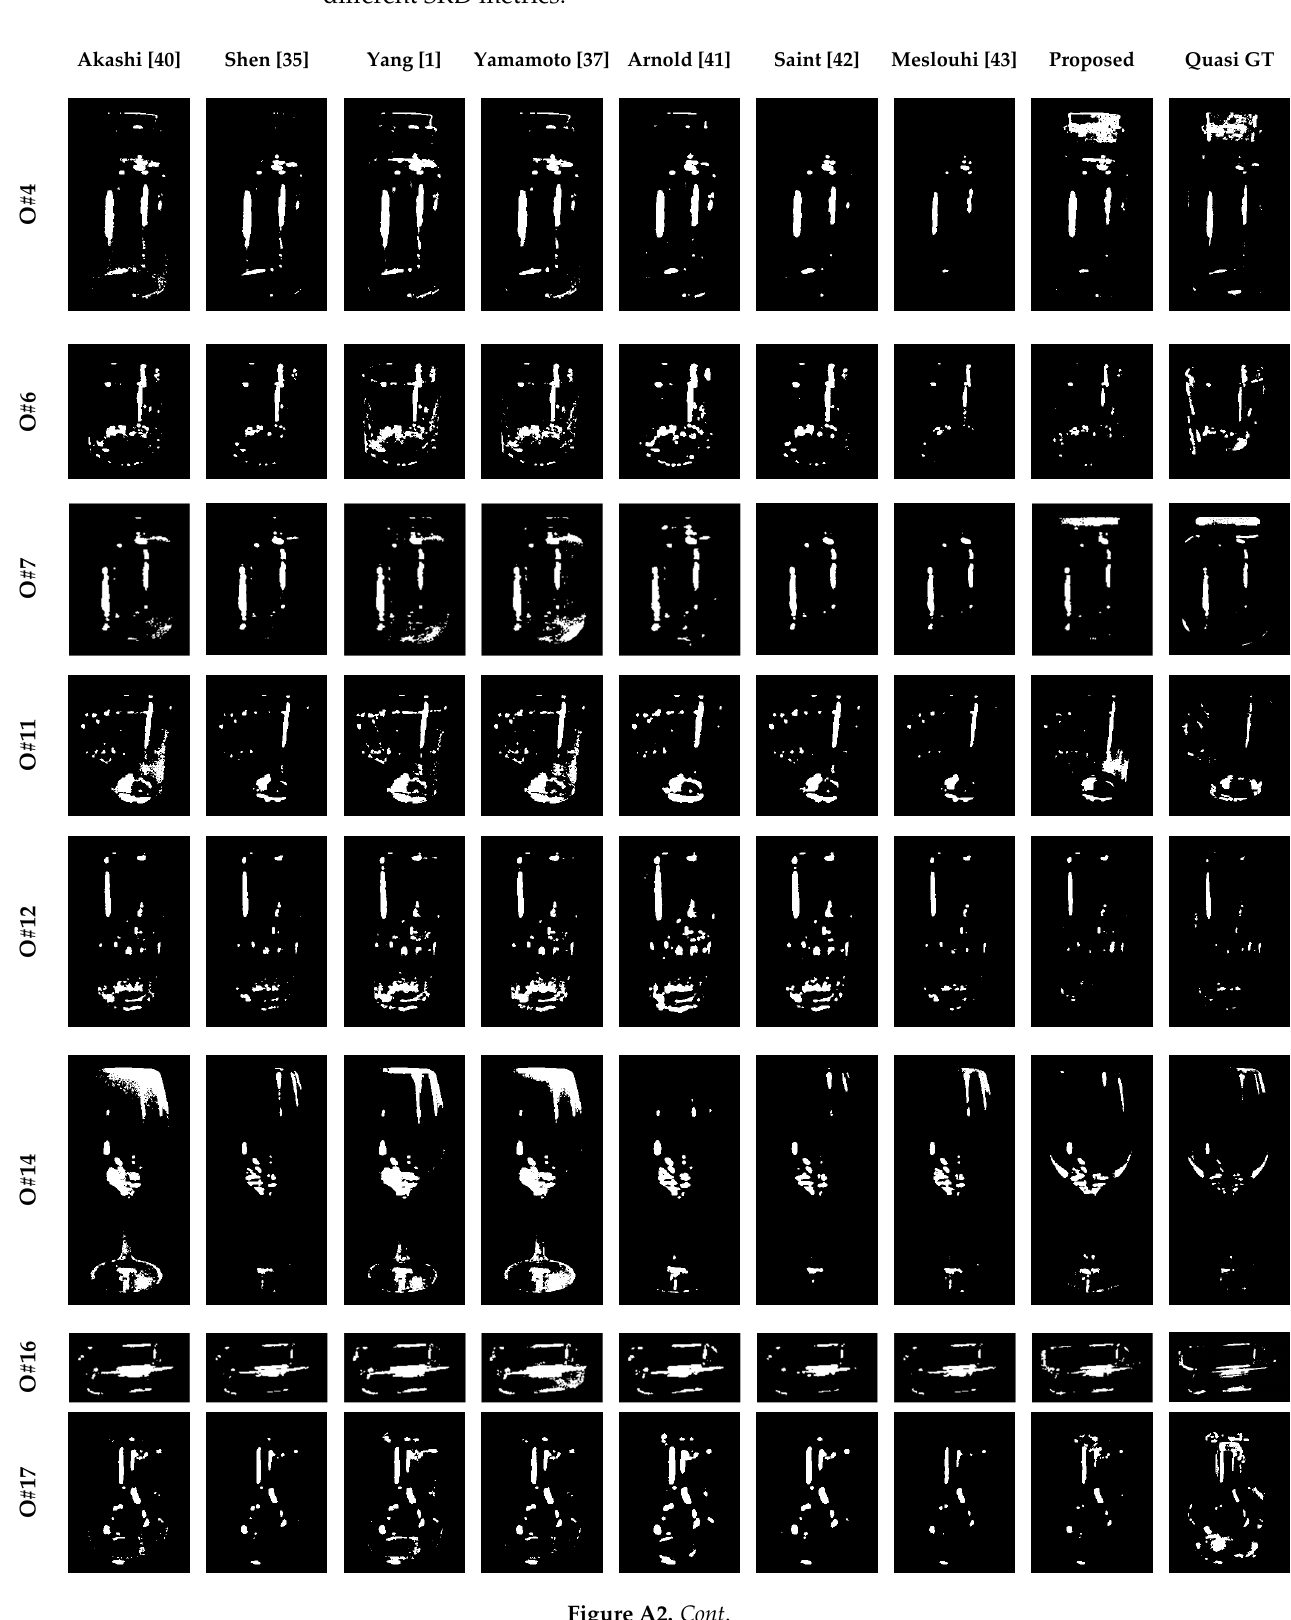
Evaluation results for SRD performances of proposed method for 122 specular re- flected images (121 sub-apertures + 1 maximum) of 9 sample objects separately using different SRD metrics.